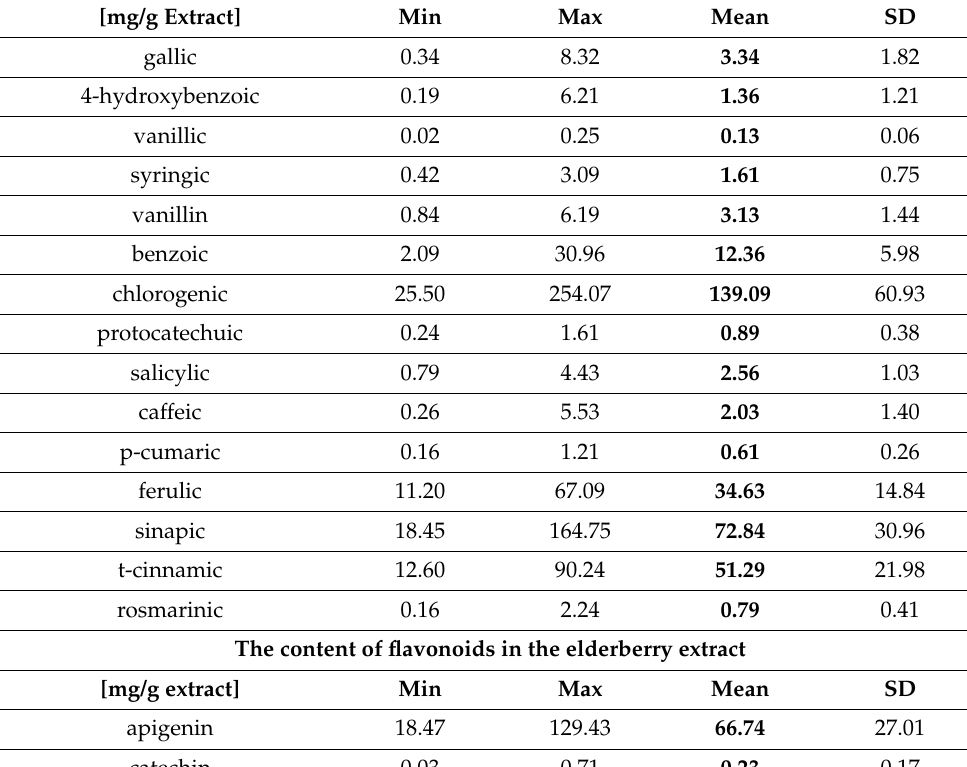
Table 2. The content of phenolic acids in the elderberry extract.